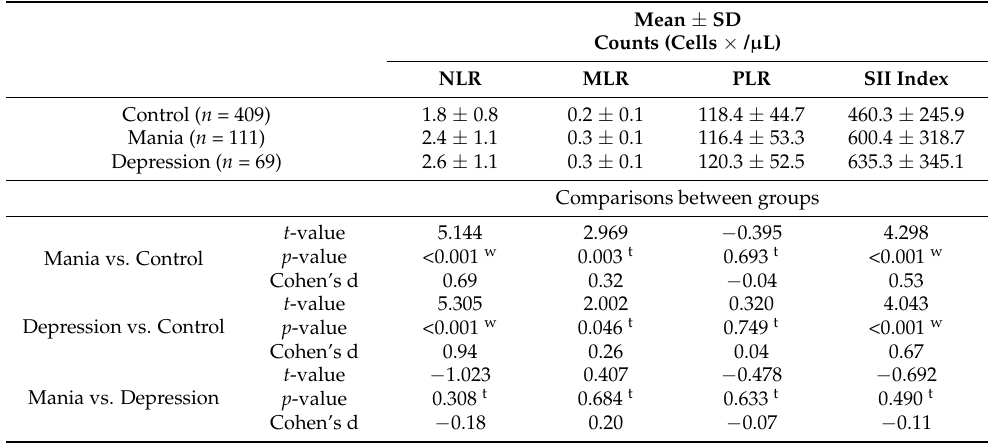
healthy controls of the study. Values are presented as mean ±